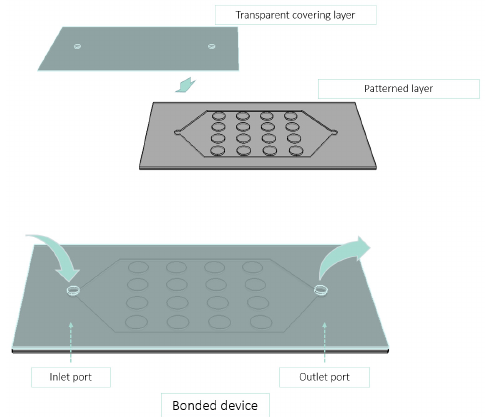
Figure 1. Simplified sandwich structure of a microfluidic device, showing the two bonded layers. The patterned layer reproduces the designed geometric features; the covering layer confines the fluid. Inlet and outlet ports can be hosted in either the patterned or the bonding layer.